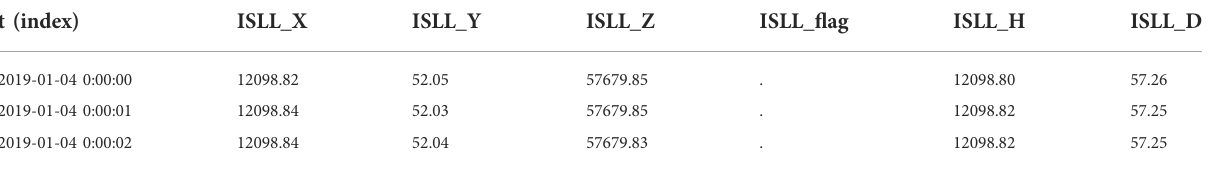
TABLE 3 Example of the returned DataFrame; in this case the carisma module. In the case of CARISMA data, the fl ag column identi fi es ok (.) and bad (x) data (bad data are replaced with